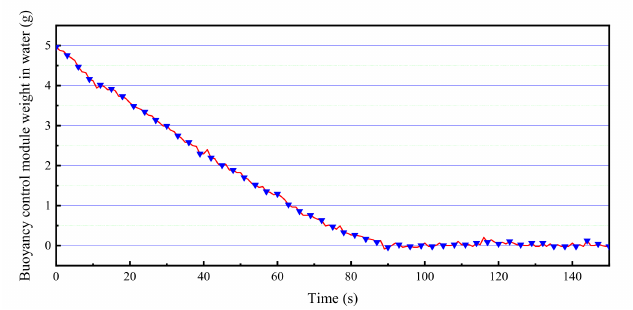
Figure 14. The weight of BCM in